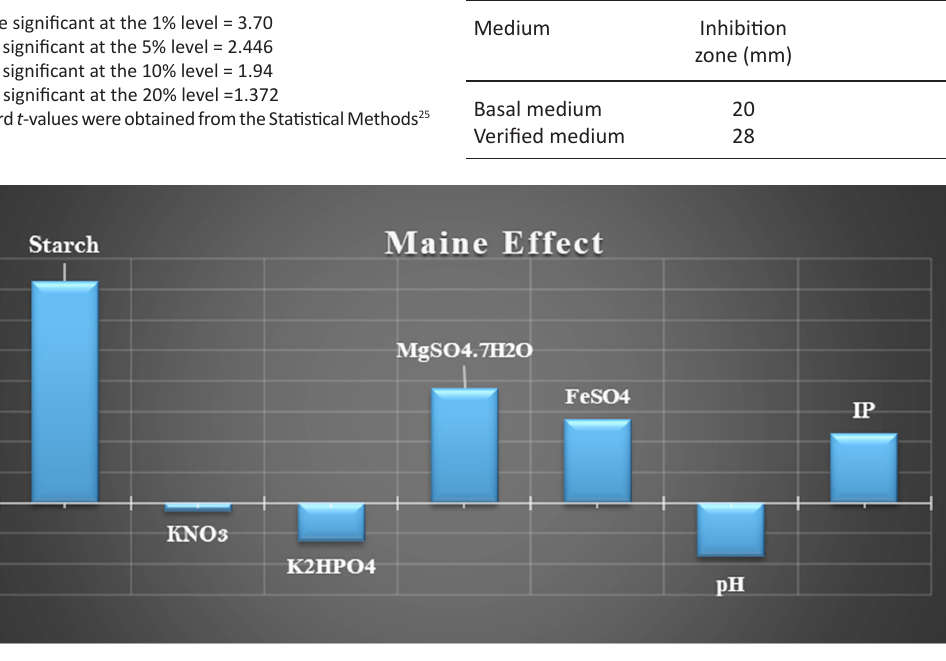
Fig. 3 . Effect of culture conditions on antagonistic agent